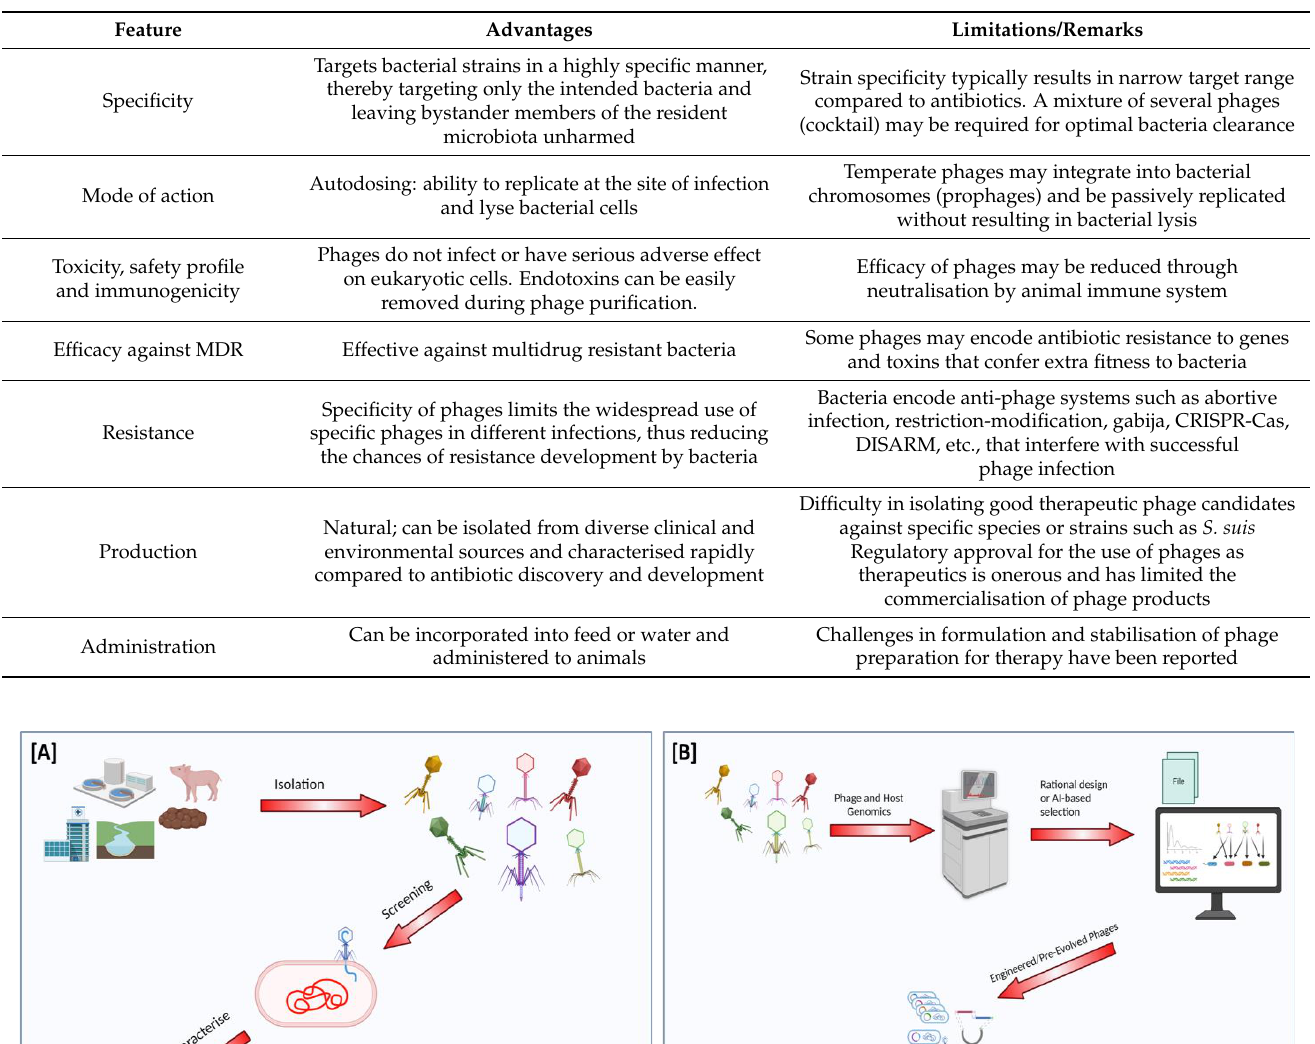
Table 1. Advantages and limitations associated with phages as antibacterial agents.